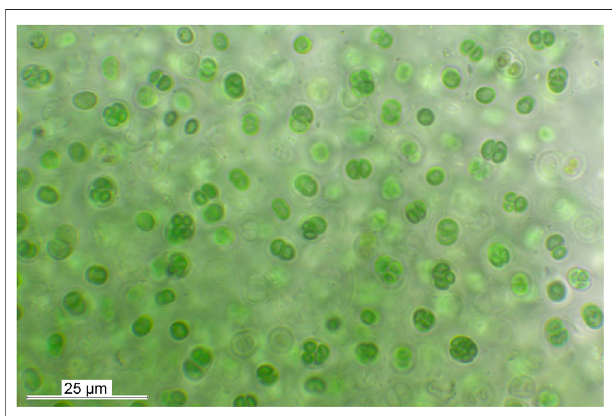
FIGURE 9 | Gloeocapsopsis dulcis , a cyanobacterium isolated from quartz hypolithic bio fi lms. Photo credit: Patrick